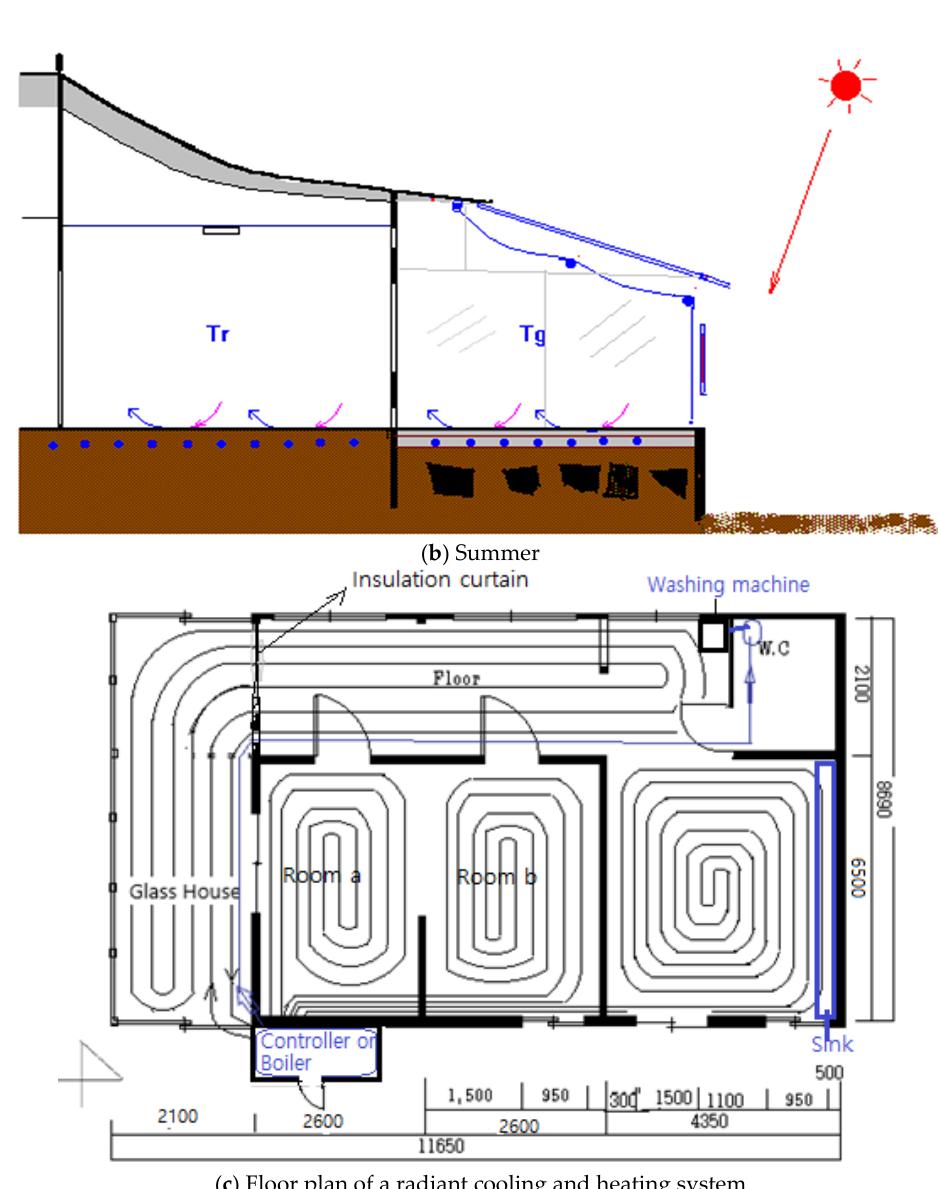
Figure 2. Section of attached glass house ( a , b ) and floor plan of a radiant cooling and heating system ( c ).